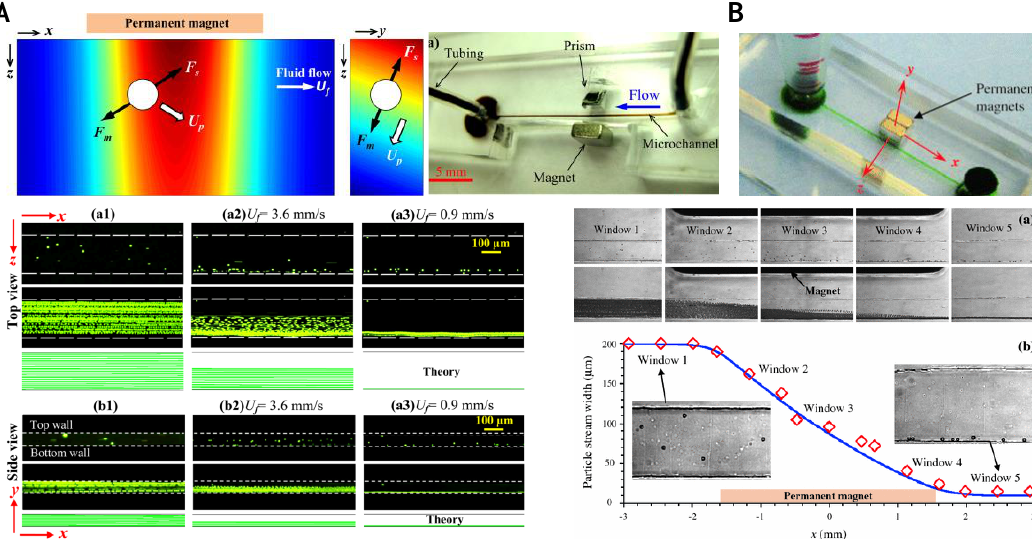
Figure 1. Diamagnetic particle deflection in the flow of magnetic fluids under a non-uniform magnetic field. ( A ) Force analyses on a diamagnetic particle in the flow of magnetic fluids in the horizontal (left) and vertical (top left) planes of a microchannel, where the background colors show the magnetic field contour; Experimental and theoretical demonstrations (bottom) of the deflection of 5 µm diamagnetic beads in 0.5 × EMG 408 ferrofluid through a straight rectangular microchannel with a nearby permanent magnet (top right). Adapted with permission from Liang et al. [79], © 2011 American Institute of Physics. ( B ) Experimental and theoretical studies (bottom) of the lengthwise development for the deflection of 10 µm diamagnetic beads in 1M MnCl 2 solution with two stacked permanent magnets (top). Adapted with permission from Zhu et al. [80], 2012 Springer.